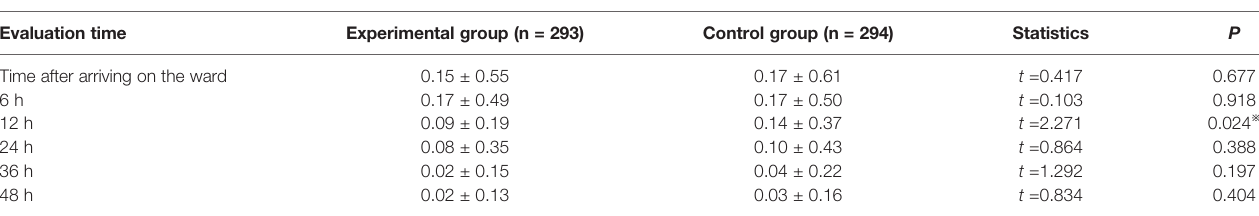
TABLE 3 | Comparison of PONV scores between the two groups. Evaluation time